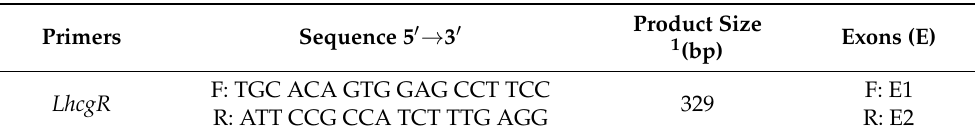
Table 1. Oligonucleotid primers used for amplification of the testicular cDNA LhcgR based on Rattus norvegicus (Accession number